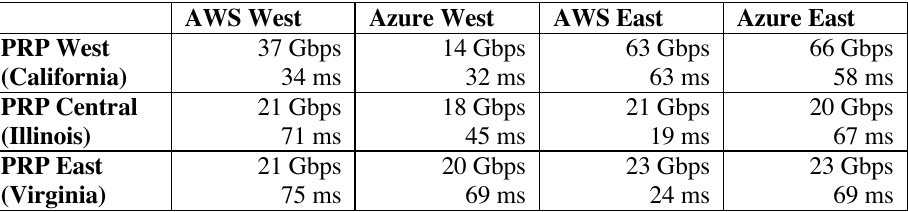
Table 3. Observed peak throughput while downloading data from OSG-operated xrootd services on PRP hardware into Cloud compute instances. Ping RTT from compute instances to the PRP hardware provided